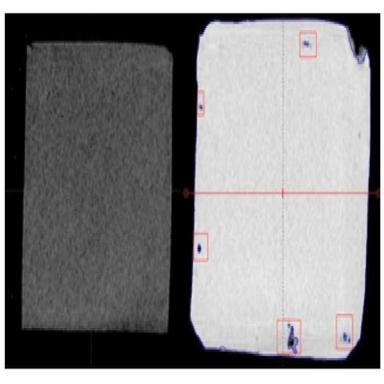
Air gaps in paraffin shown in the squares. The formation of air gaps is generated during the process of drying and customizing the paraffin bolus. These deformations can be evidenced both on the surface of the sheets and on CT images.